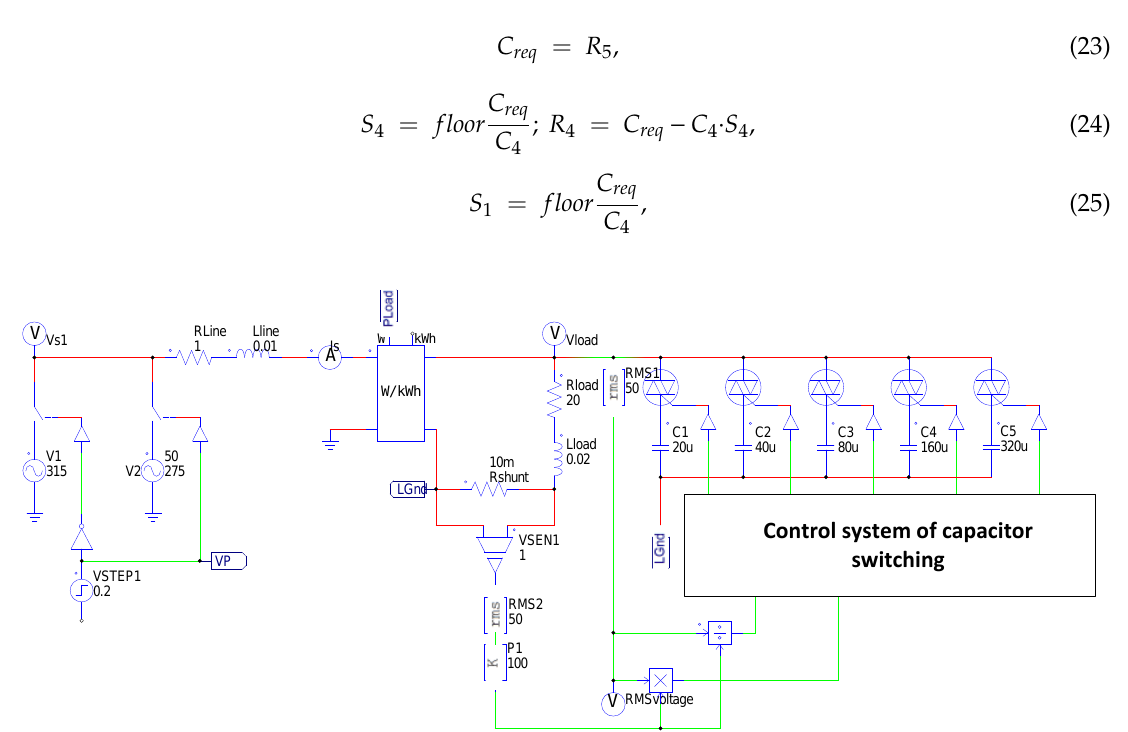
Figure 8. The block diagram for the proposed control system.